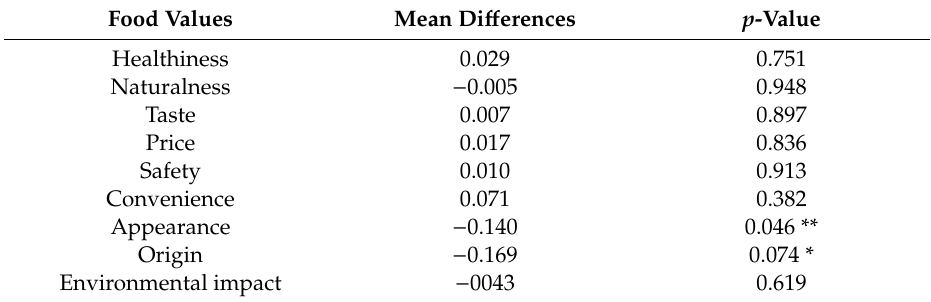
Table 5. t -test for equality of mean between “informed” and “non-informed” groups. Food